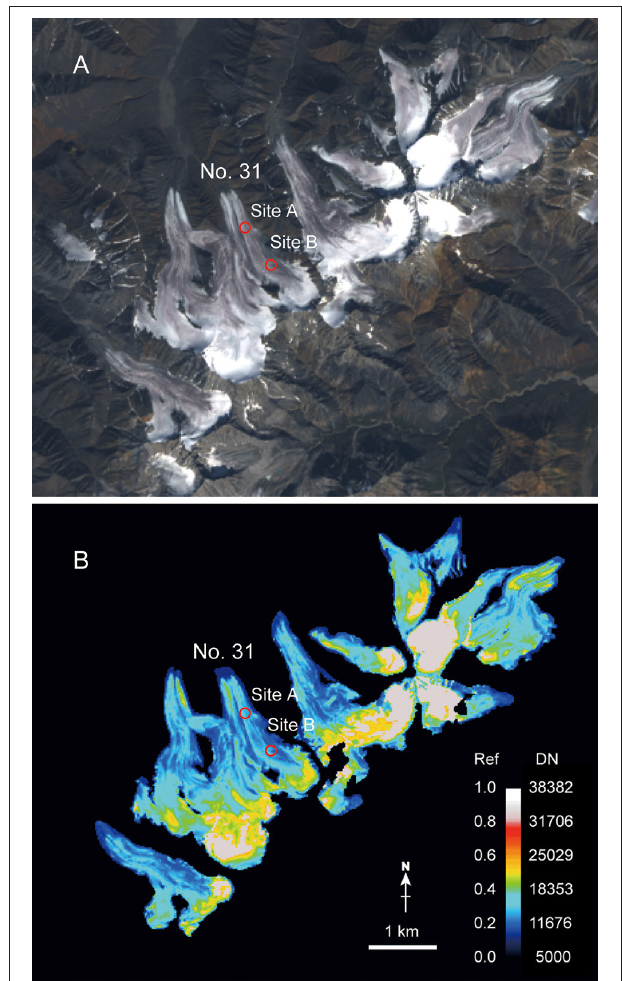
FIGURE 5 | Landsat-8 satellite image (OLI) acquired on 11 August, 2014 over Glacier No. 31 and surrounding glaciers in the Suntar-Khayata Range in Russian Siberia. (A) RGB natural color composite image of band 2, 3, and 4, (B) band 2 reflectivity image of the glacier ice area highlighted with a color look-up-table. Black and white areas denote non-glacier area and snow area derived from band 5 image, reflectively. The color scale is assigned to digital number (DN) and reflectivity (Ref) as shown by the color